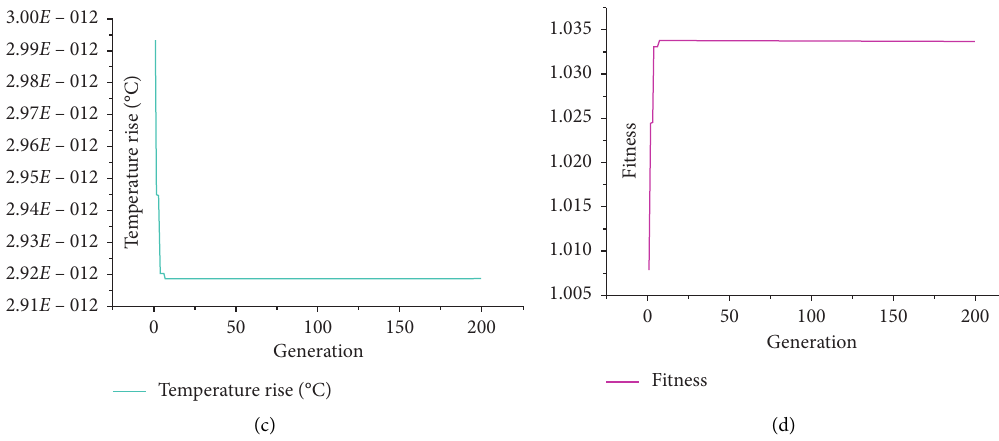
Figure 8: Optimization results with minimum temperature rise without RTA time constraint.